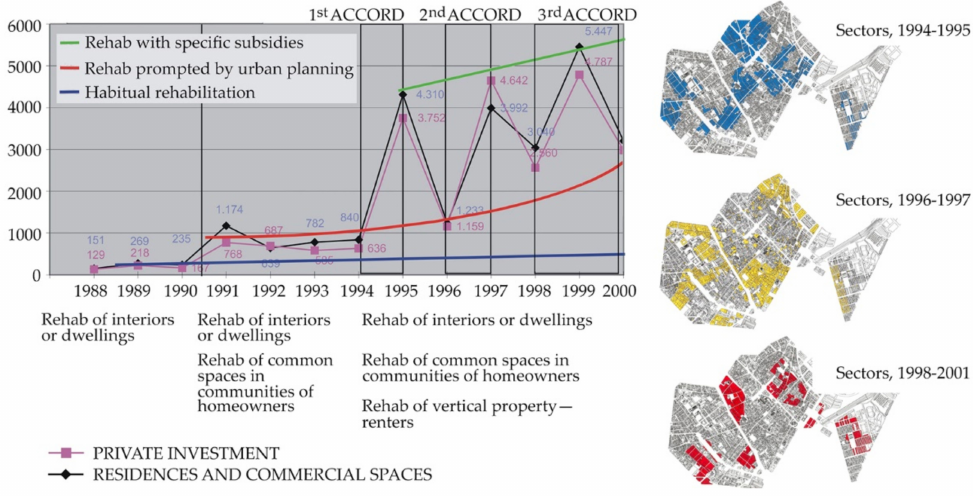
Figure 4. Evolution of publicly subsidized, private rehabilitations of homes in Ciutat